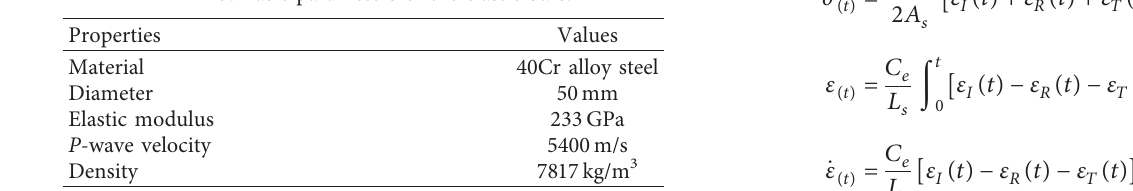
Table 3: Basic parameters of the elastic